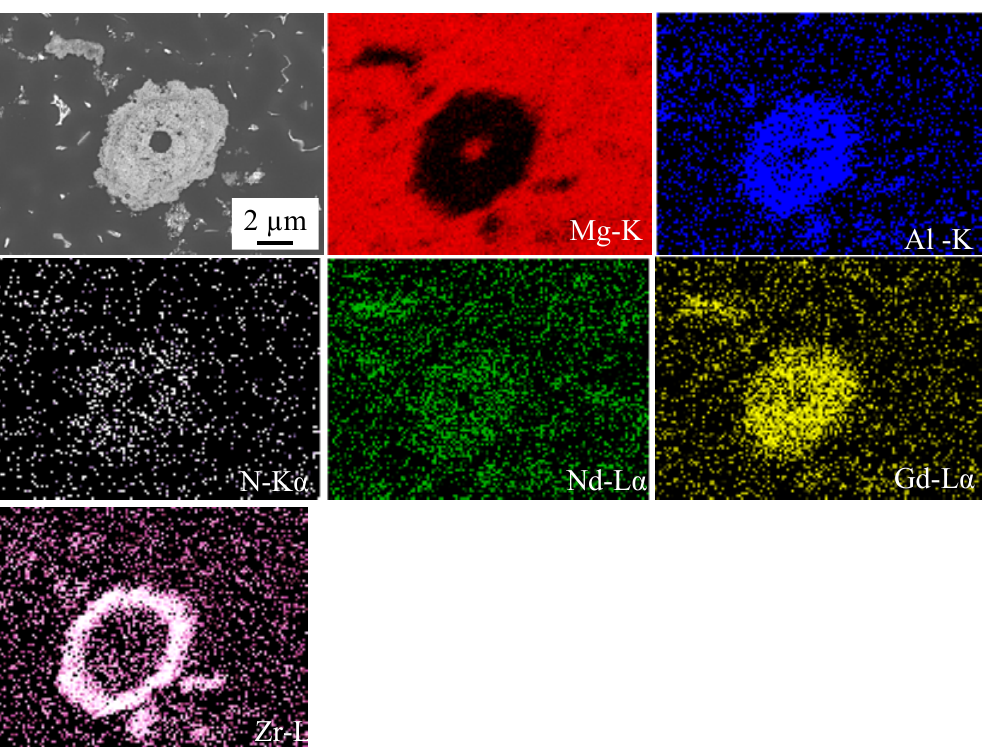
Figure 10. EDS mapping of El21–1.0 wt.%AlN nanocomposite near to a big agglomerate.